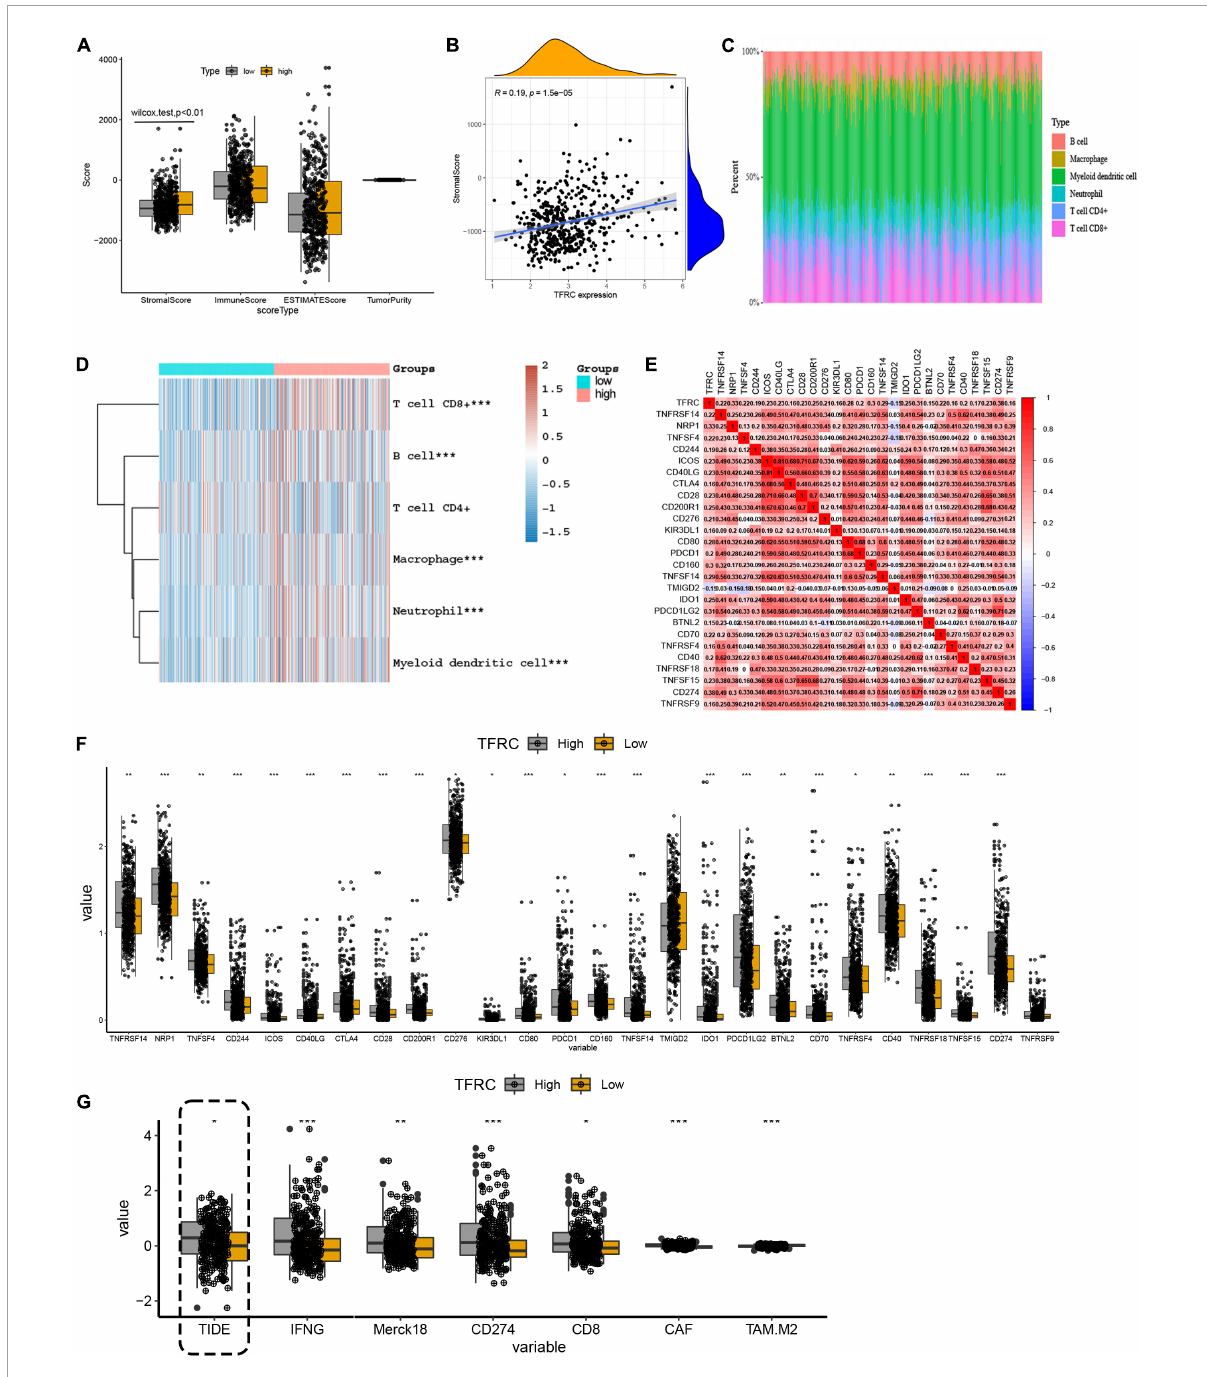
FIGURE5 The influence of TFRC on tumor microenvironment, immune checkpoints, and ICB response in LGG. (A,B) Microenvironment scores. (C) Distribution of immune cells. (D) TFRC mRNA expression relationship with different immune cells in TCGA LGG tissue. (E,F) The influence of TFRC expression level on immune checkpoints. (G) The influence of TFRC expression level on the ICB response. * p < 0.05, ** p < 0.01, *** p <